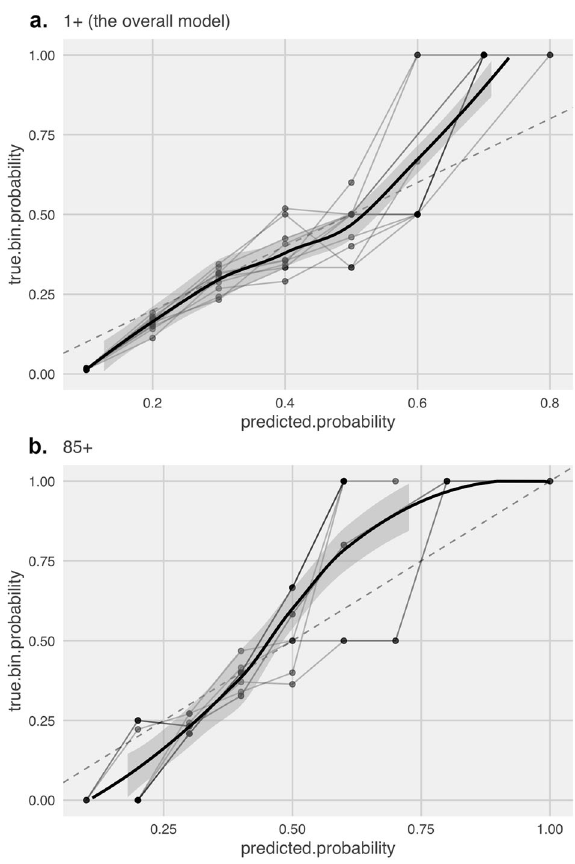
Fig. 2 Calibration curves of models. a The calibration curve for the overal model. b The calibration curve for the 85 +